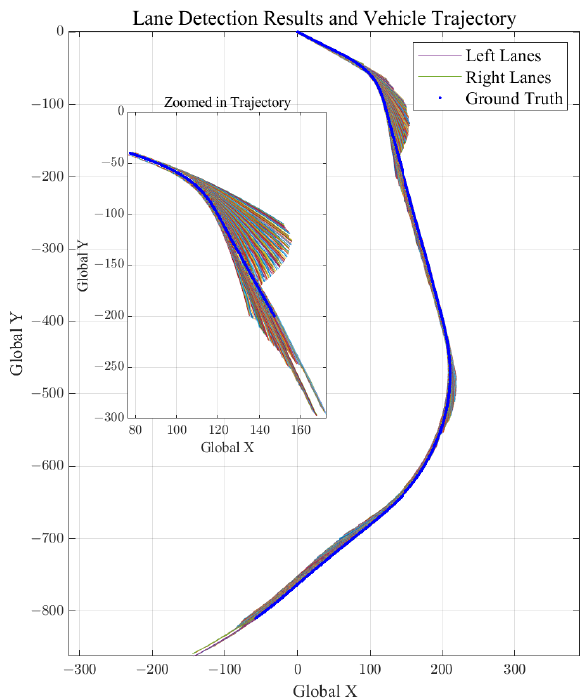
Figure 8. A lane detection result including up to 100 m previewed points is plotted with the vehicle position measured by OxTS RT3100 (vehicle position marked blue). As shown in the figure, longer preview distance show huge lateral deviation from the ground truth.